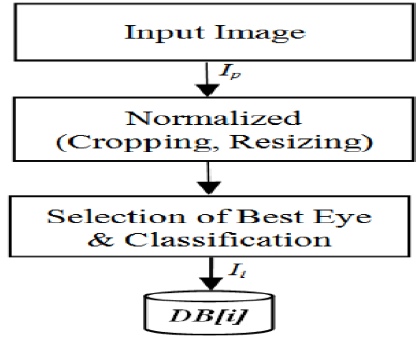
Figure 4: Flowchart for creation of database DB[i] for experimental analysis of proposed GDE algorithm.